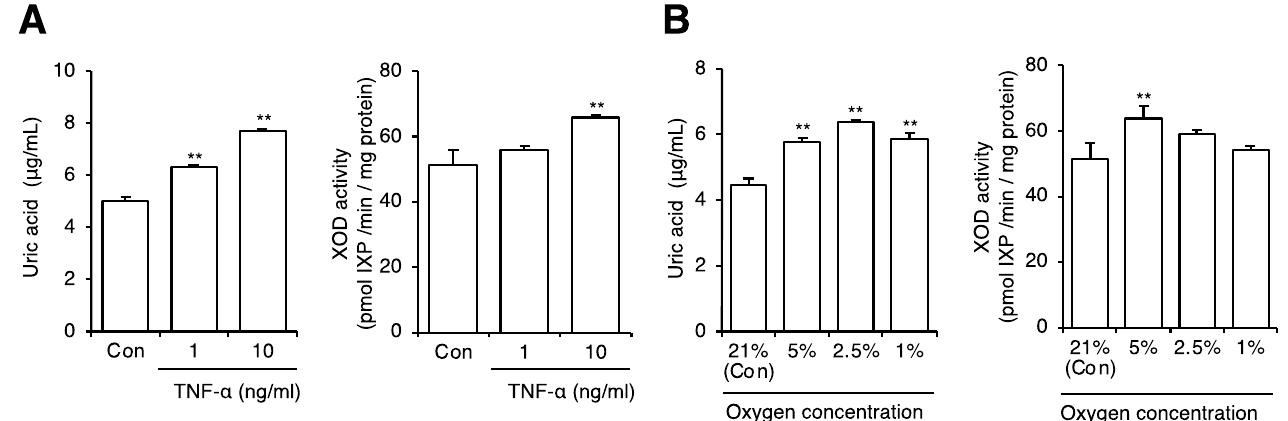
Figure 6. Effects of TNF- α and hypoxic stress and on uric acid production by 3T3-L1 adipocytes. Data are means ± SE for 3 independent experiments. Statistical analysis was performed using one-way analysis of variance (ANOVA) and post hoc tests (Tukey–Kramer multiple comparisons). Asterisks indicate significant differences compared to the control at p < 0.01. Matured adipocytes were cultured under hypoxic conditions ( A ) or stimulated with TNF- α ( B ). Uric acid release into the media and cellular XOD activity were measured.